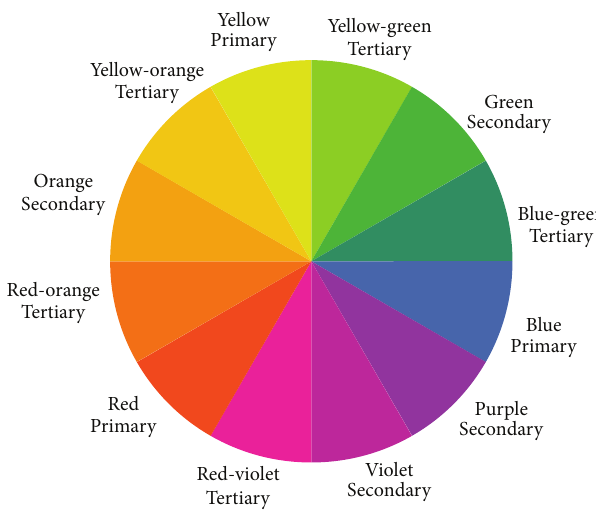
Figure 3: The 24 color